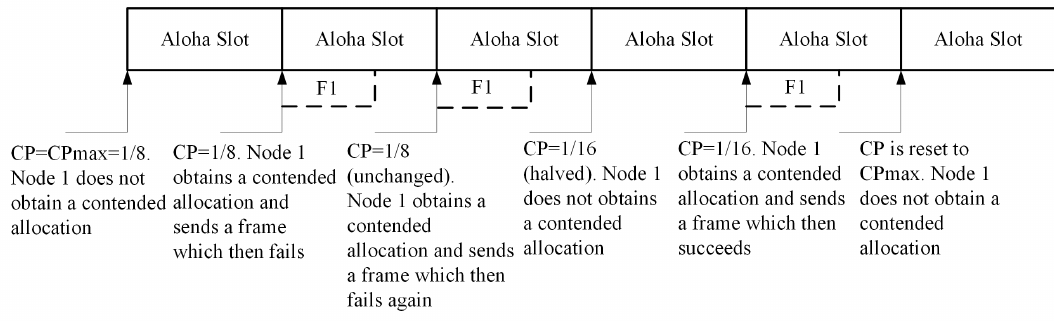
Figure 6. Slotted Aloha access